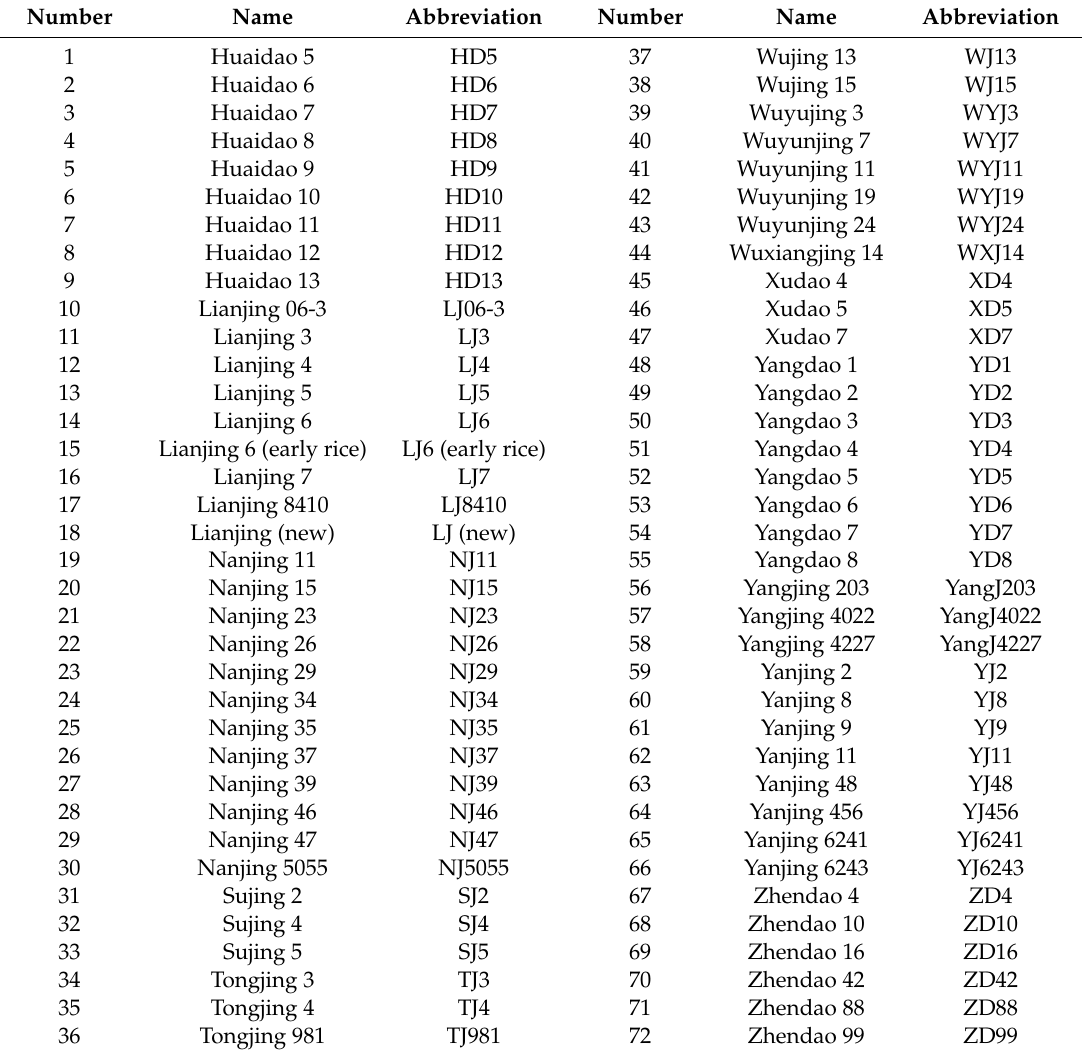
Table 1. Rice cultivars from Jiangsu